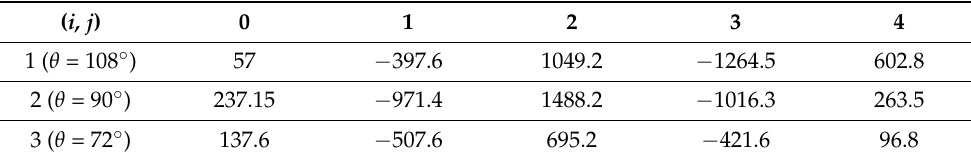
Figure 7. Scattering indicatrix measured for milk samples having a nominal fat percentage of 1.5%: without large-scale impurities (black circles), with the addition of somatic cells (SC) at a concentra- tion level of 10 6 cm − 3 (red circles). Milk flow velocity in the tube is zero. The temperature is 20 °C. Laser wavelength is 532 nm. Note that the addition of somatic cells has little effect on the intensity ratio of side and back scatter, that is, on the scatterometric parameter at the angles (72°, 90°, 108°). This